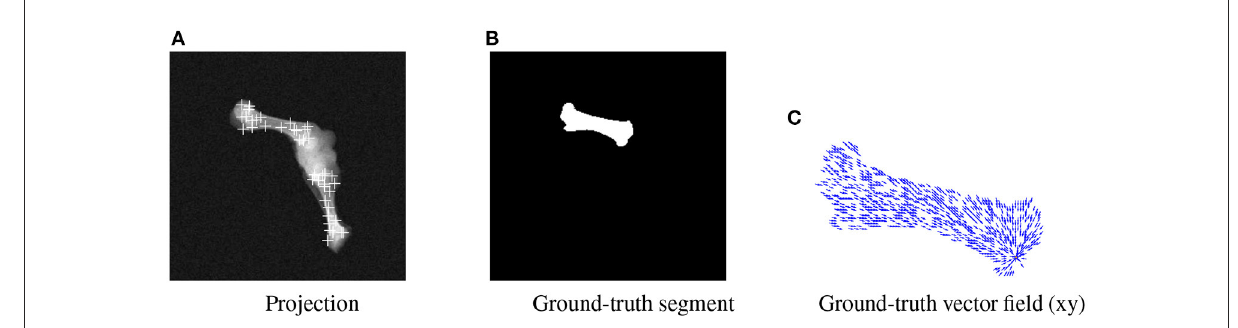
FIGURE4 Visualization of an input projection (A) with the femur’s and tibia’s 2D landmarks, a femur segment (B) , and the vector field (blue arrows) of a landmark (orange) (C) .